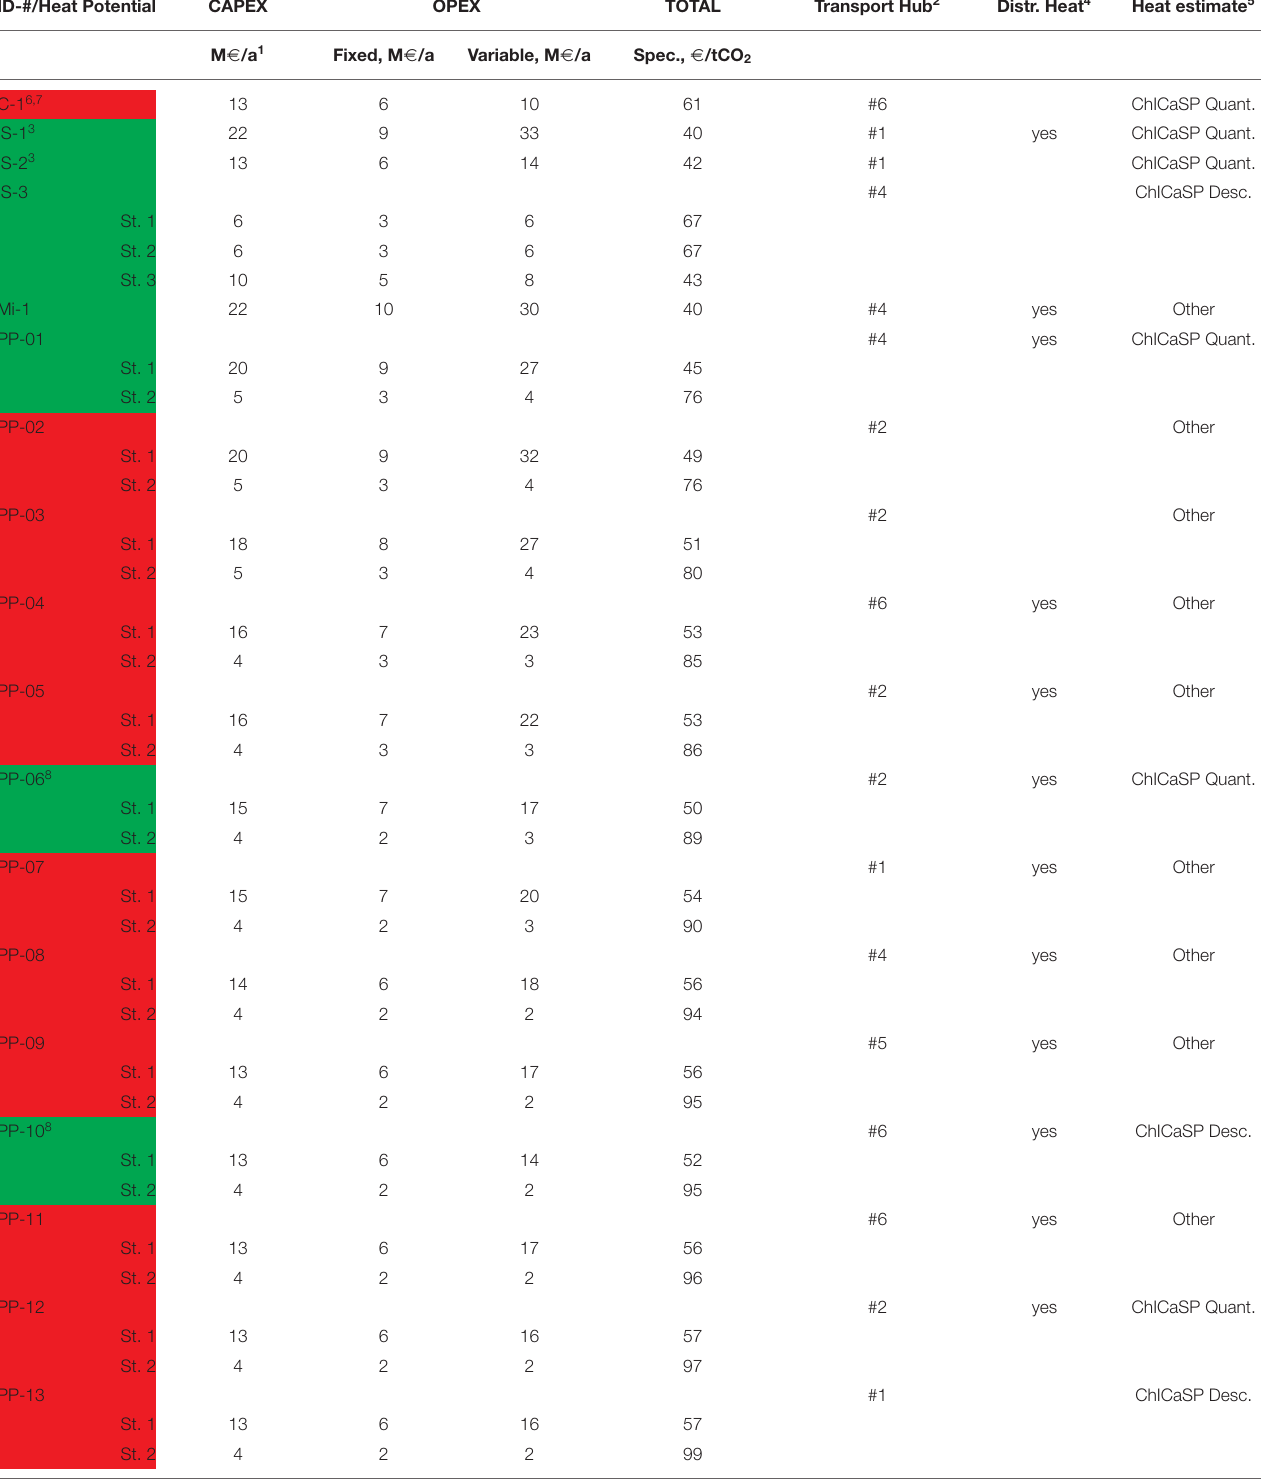
TABLE 5 | Mapping of potential for implementing carbon capture and storage at Swedish emission sources > 500 kt/a. ID-#/Heat Potential CAPEX OPEX TOTAL Transport Hub 2 Distr. Heat